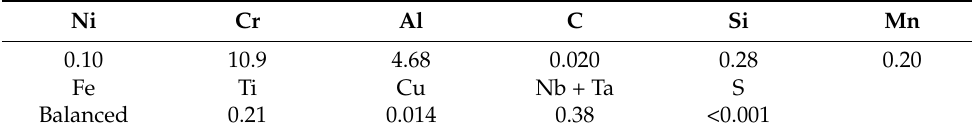
Table 3. Elementary composition of weld wire